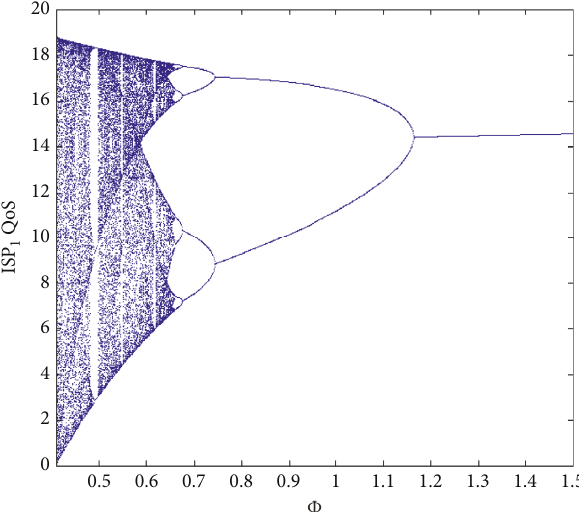
Figure 17: Bifurcation diagrams of q